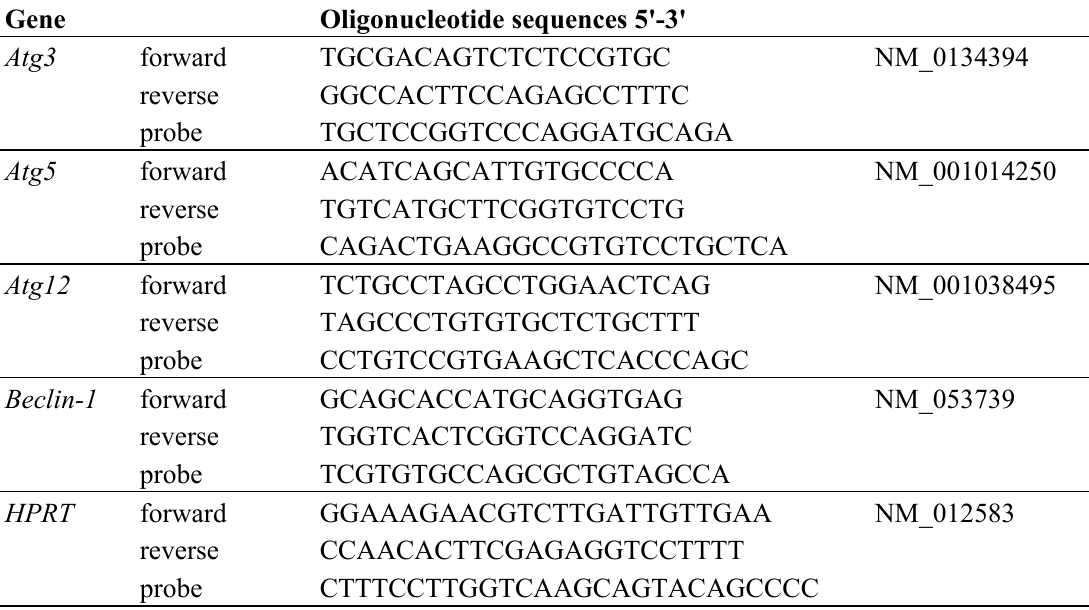
Table 1. Sequences of oligonucleotides and gene locus. HPRT: Hypoxanthine-guanine phosphoribosyl-transferase; Atg: autophagy-related gene